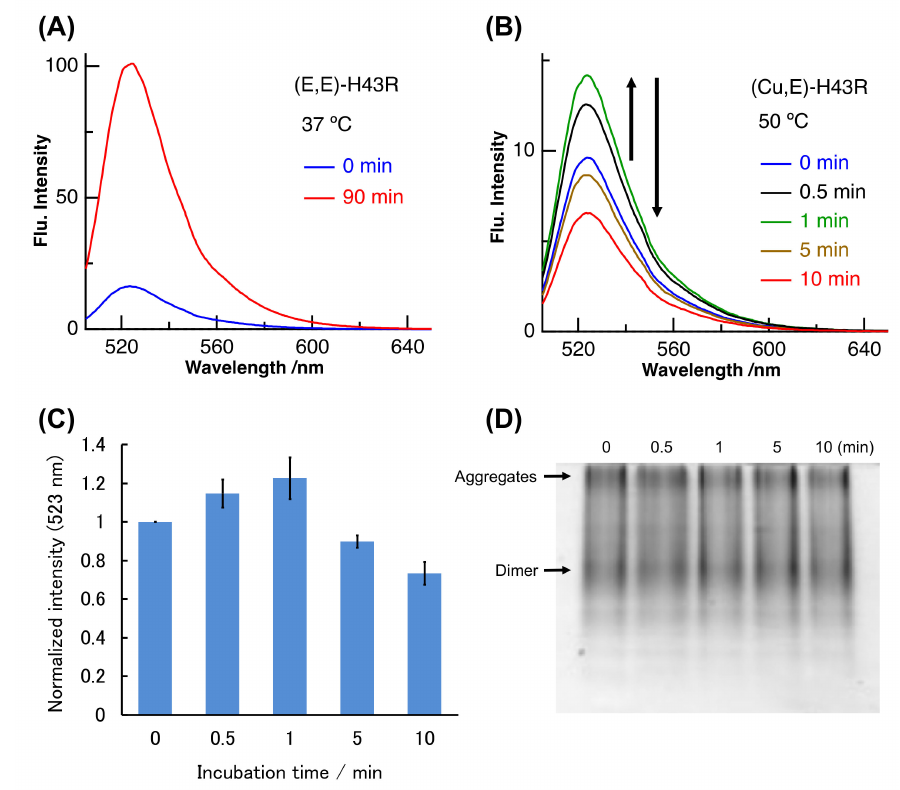
Figure 2. ( A – C ) Pro-oxidant activities after different incubation times in phosphate buffer. ( A ): (E,E)-H43R at 37 ◦ C, ( B ): (Cu,E)-H43R at 50 ◦ C. The dichlorofluorescein (DCF) fluorescence intensities normalized by the value at 0 min for ( B ) are shown in ( C ). Error bars are SE ( n = 3). Pro-oxidant activity was measured by the fluorescence intensity of DCF generated by the oxidation of dichlorodihydrofluorescein (DCFH) (50 µ M) by protein (10 µ M) and H 2 O 2 (50 µ M) at room temperature. CuCl 2 (20 µ M) was also added in (A) before the fluorescence measurement. ( D ) Native-poly acrylamide gel electrophoresis (PAGE) of (Cu,E)-H43R in phosphate bu ff er after the indicated incubation